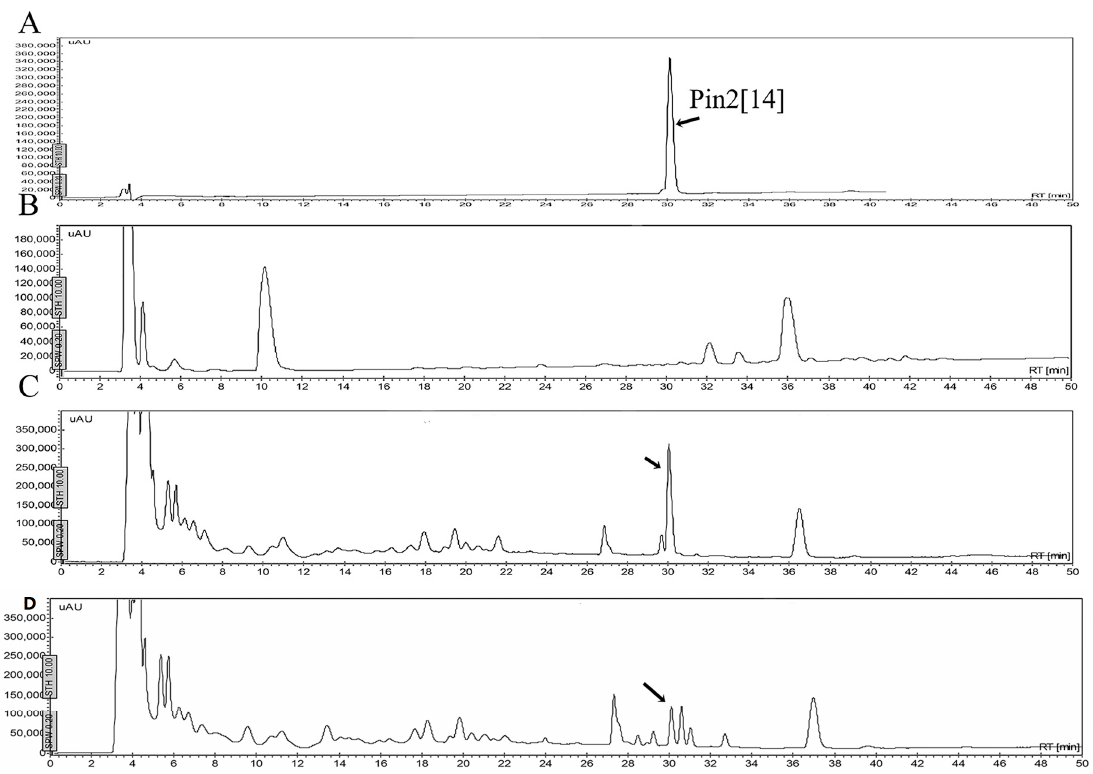
Figure 8. Stability of Pin14[G] in human blood plasma and bacterial supernatants. The peptide was either diluted in human blood or bacterial supernatants, incubated at 37 °C for 12 h and then extracted. ( A ) Pin14[G] was separated by HPLC (control); ( B ) Pin14[G] was diluted with blood, incubated for 12 h at 37 °C, extracted and separated by HPLC; ( C ) Pin14[G] was diluted with Staphylococcus aureus supernatant, incubated for 12 h at 37 °C, extracted and separated by HPLC; and ( D ) Pin14[G] was diluted with Pseudomonas aeruginosa supernatant, incubated for 12 h at 37 °C, extracted and separated by HPLC. The arrows show the presence of Pin14[G].